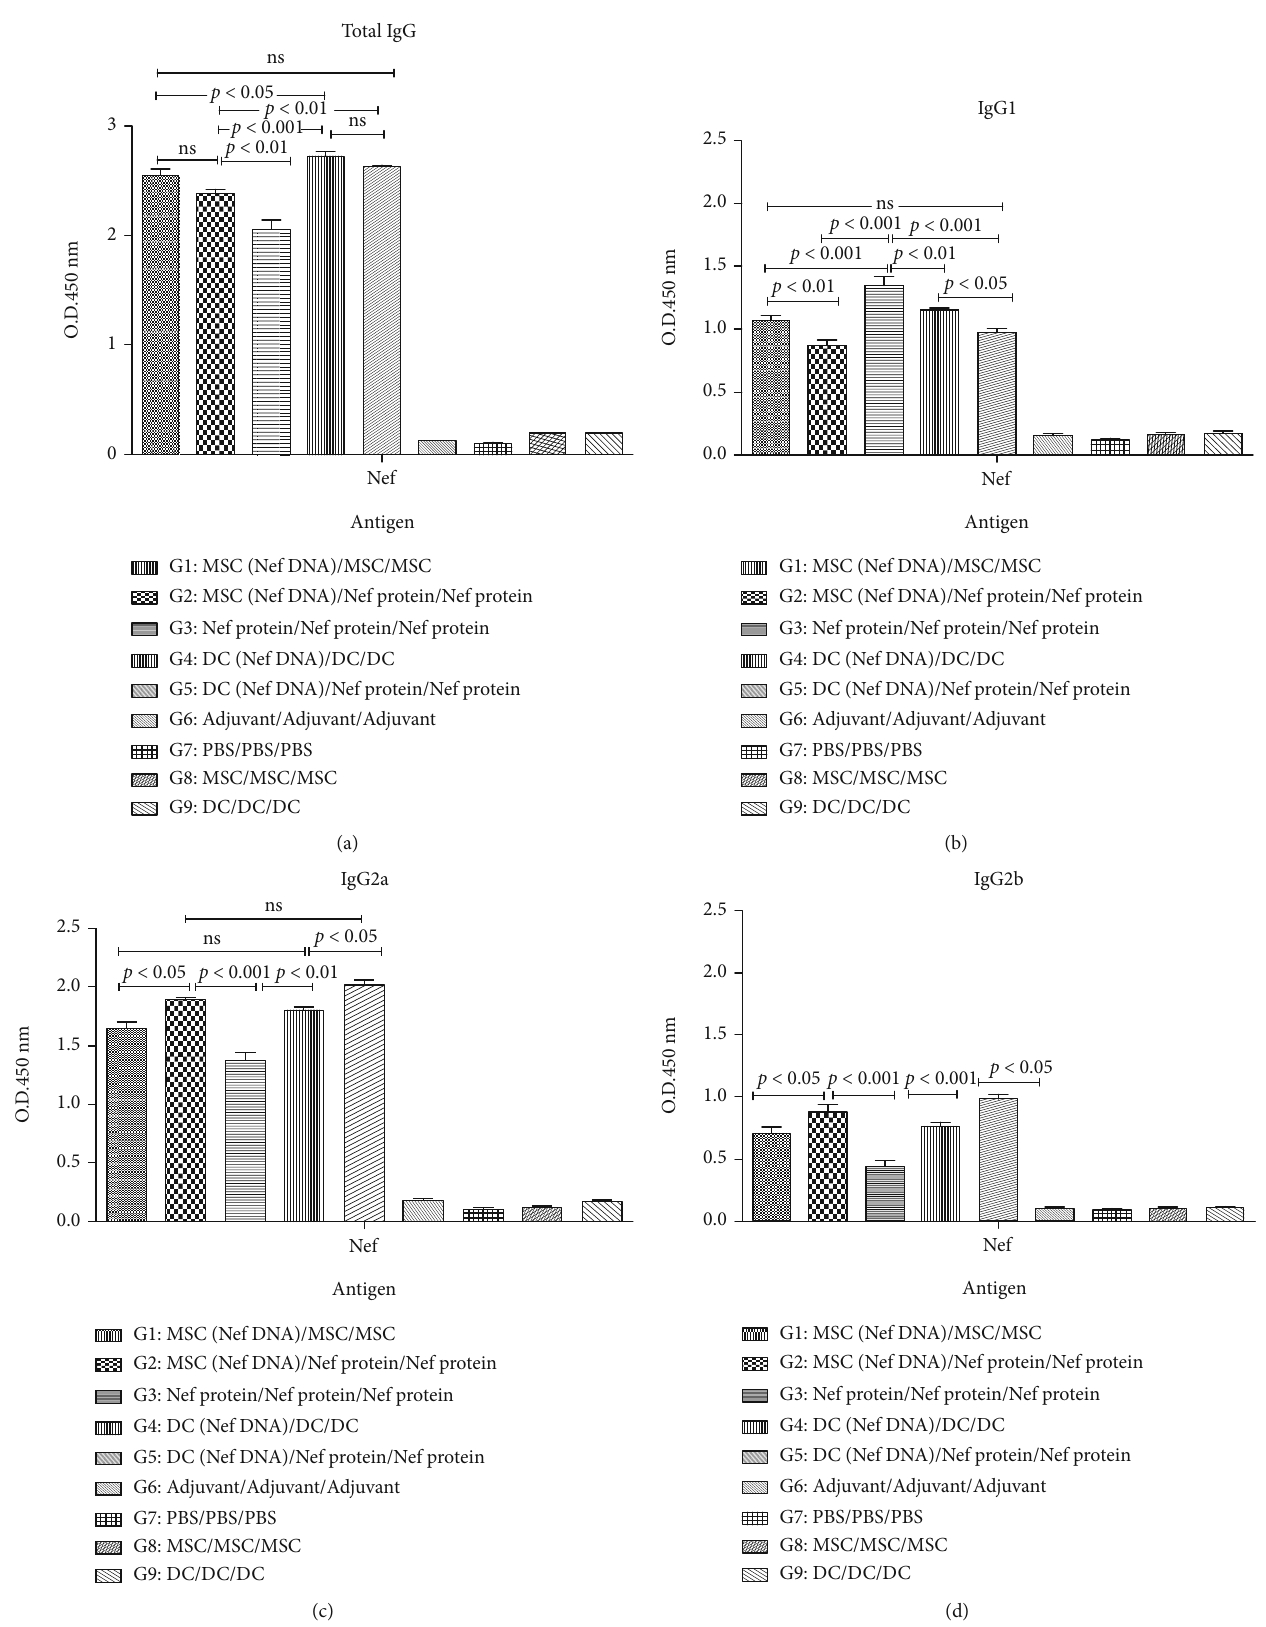
Figure 5: Antibody responses (total IgG: (a), IgG1: (b), IgG2a: (c), and IgG2b: (d)) against rNef protein in di ff erent regimens: all analyses were performed in duplicate for each sample. The results were shown as mean absorbance at 450 nm ± SD